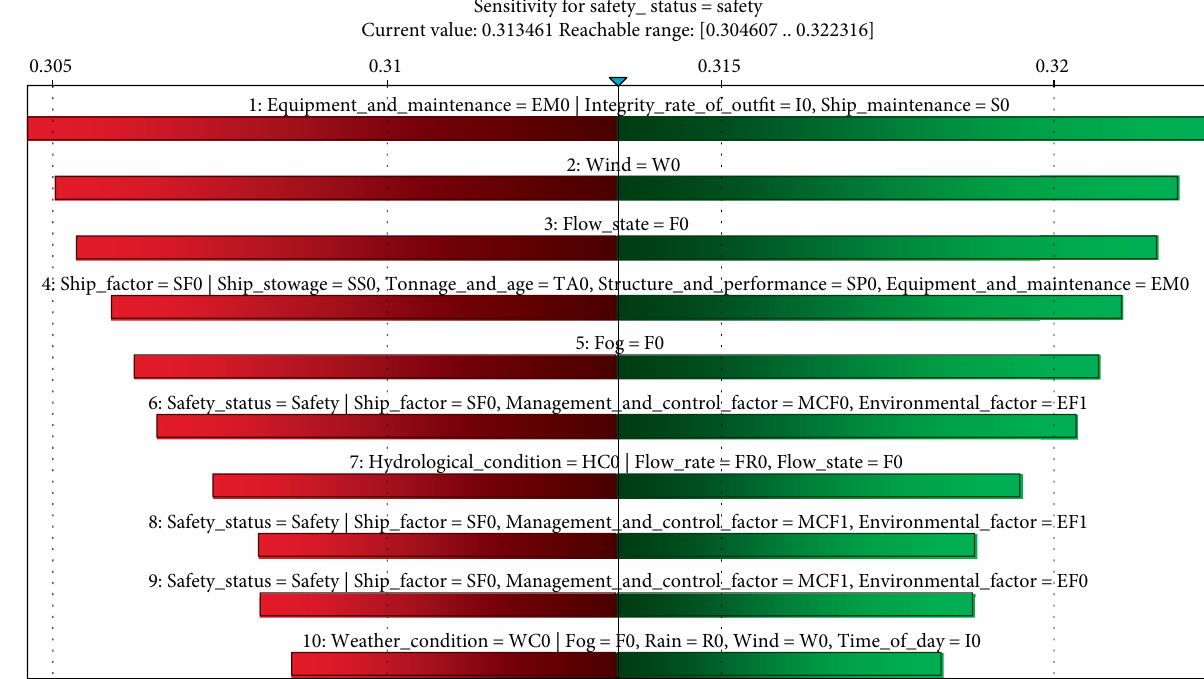
Figure 7: Tornado diagram of sensitivity for “Safety_status =